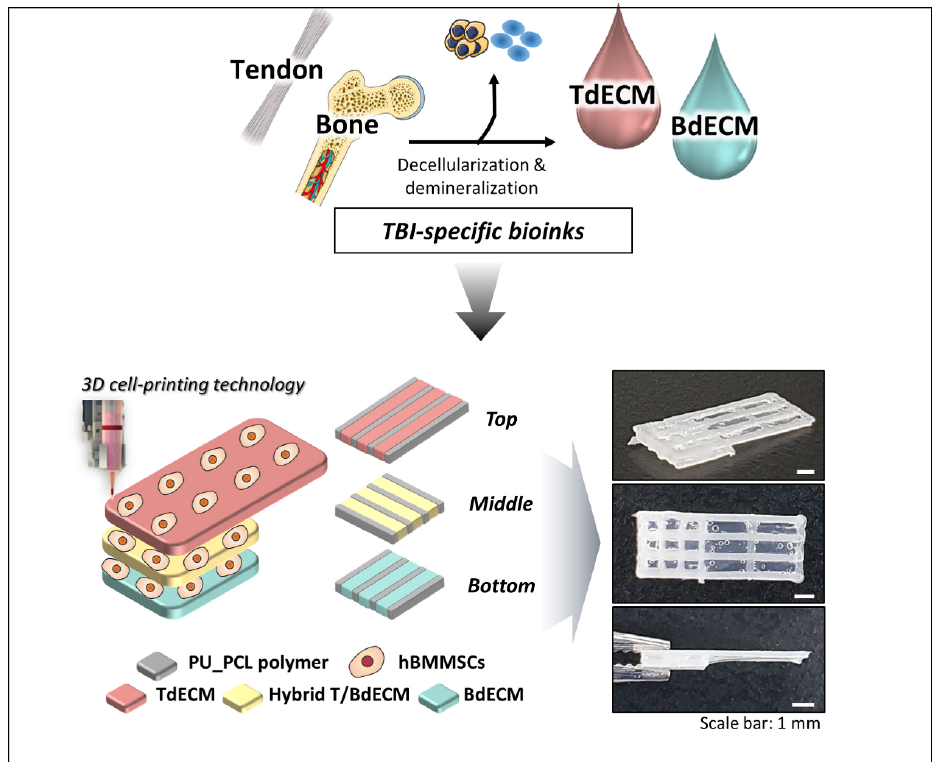
Figure 12. Illustration of how tendon and bone dECM bioinks with hBMSCs in different layers create unique 3D bioprinted scaffolds for RC regeneration. Adapted from [80].